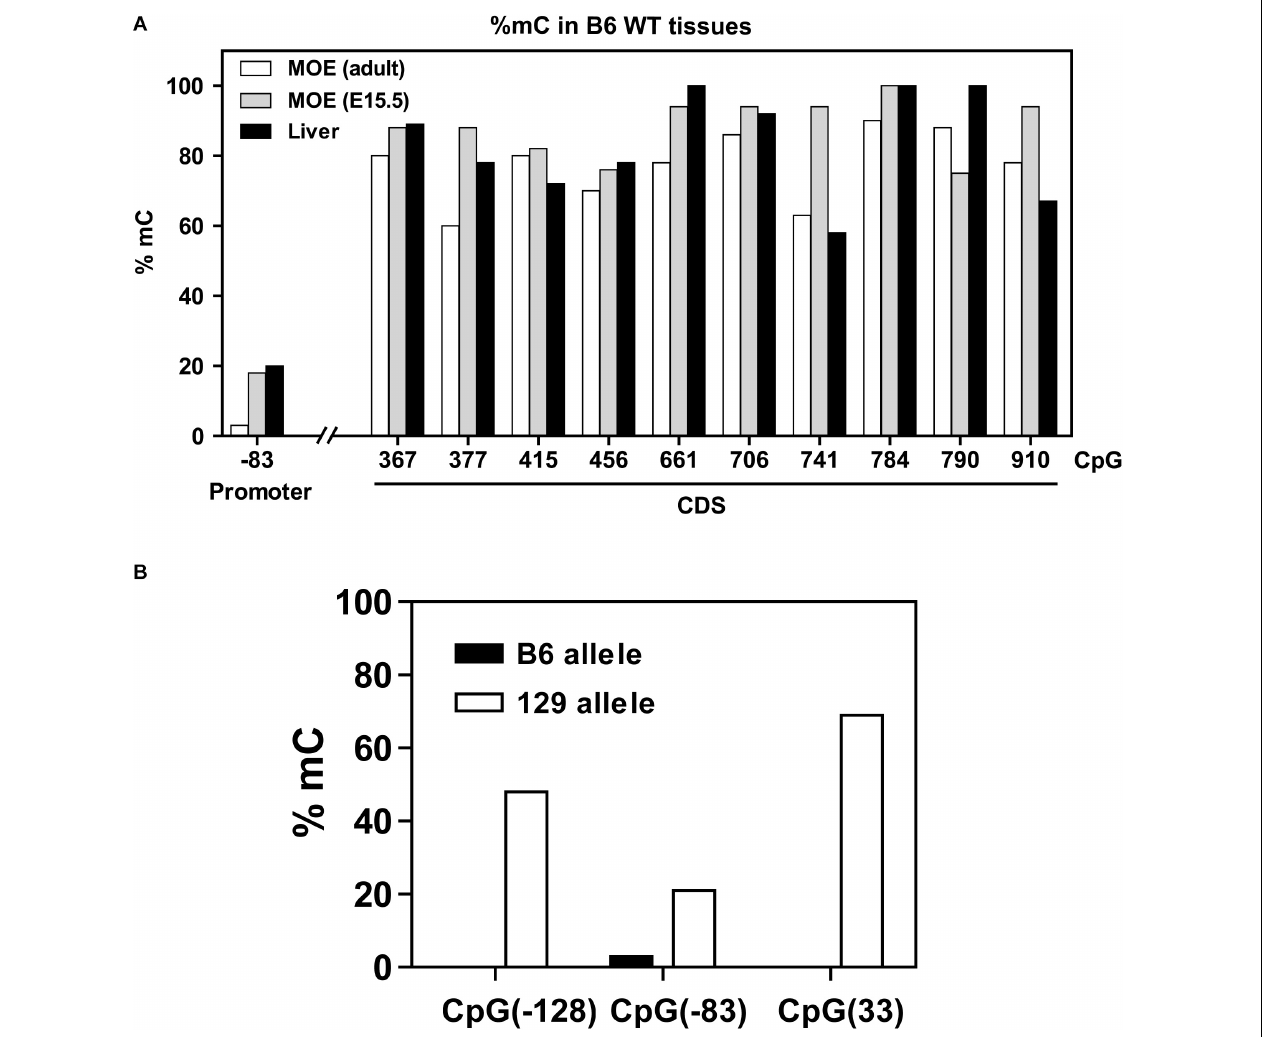
FIGURE 3 | DNA methylation in the Olfr17 gene. (A) The CpG methylation frequencies in the promoter and coding regions of the Olfr17 gene are shown. The frequencies are given by the number of clones that retain cytosine after bisulfite conversion in each position divided by the total number of clones analyzed. Olfr17 cytosine methylation was analyzed in olfactory mucosa from adult mice (MOE, adult), olfactory mucosa from E15.5 mouse embryos (MOE, E15.5) and liver. (B) Comparison of the methylation frequencies of the CpGs in the Olfr17 promoter region from the B6 and 129 alleles in the P2-GFP mice.